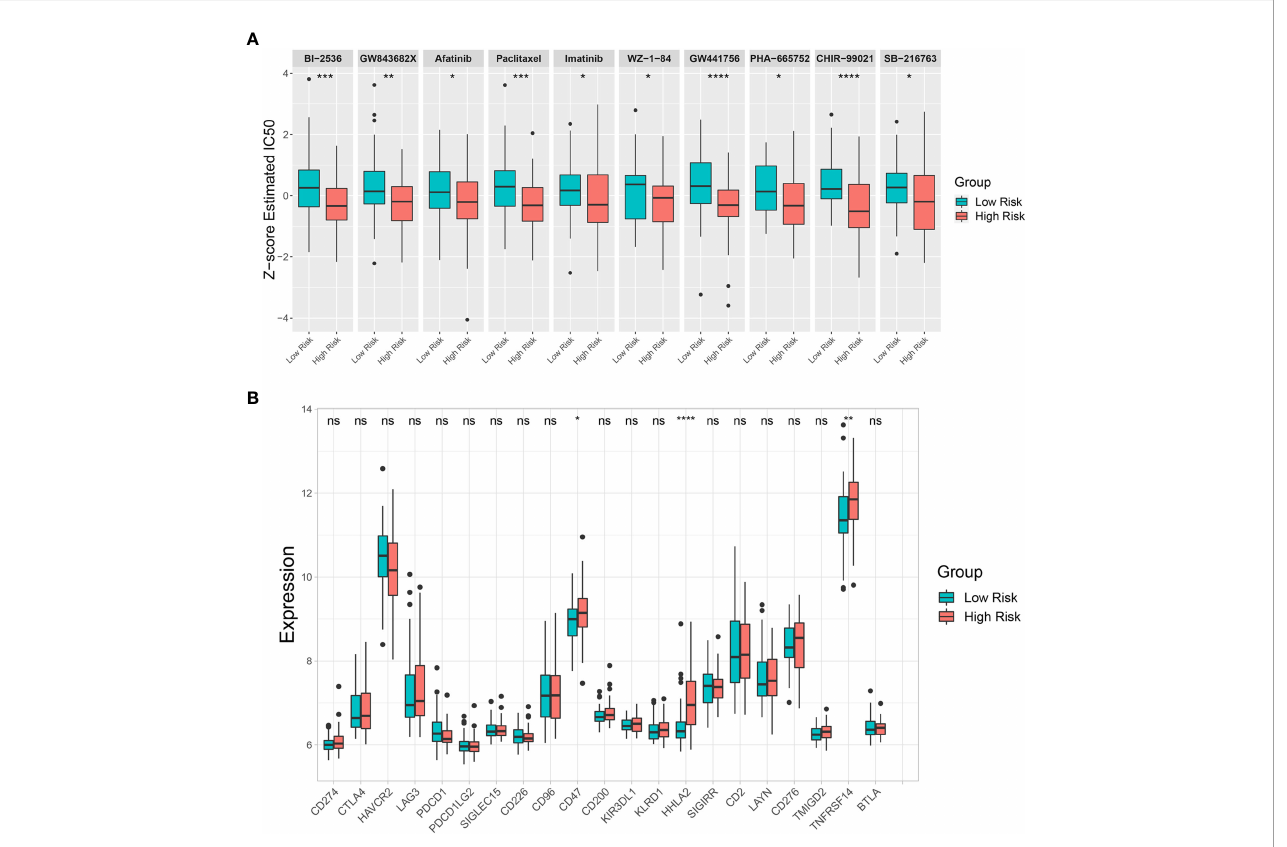
FIGURE 8 Drug sensitivity prediction and immune checkpoint analysis. (A) Differences in estimated half-maximal inhibitory concentration (IC 50 ) between risk groups for 10 candidate drugs. (B) A box plot comparing immune checkpoint marker expression levels between risk groups. Key: ns, not signi fi cant; *p < 0.05; **p < 0.01; ***p < 0.001; ****p <